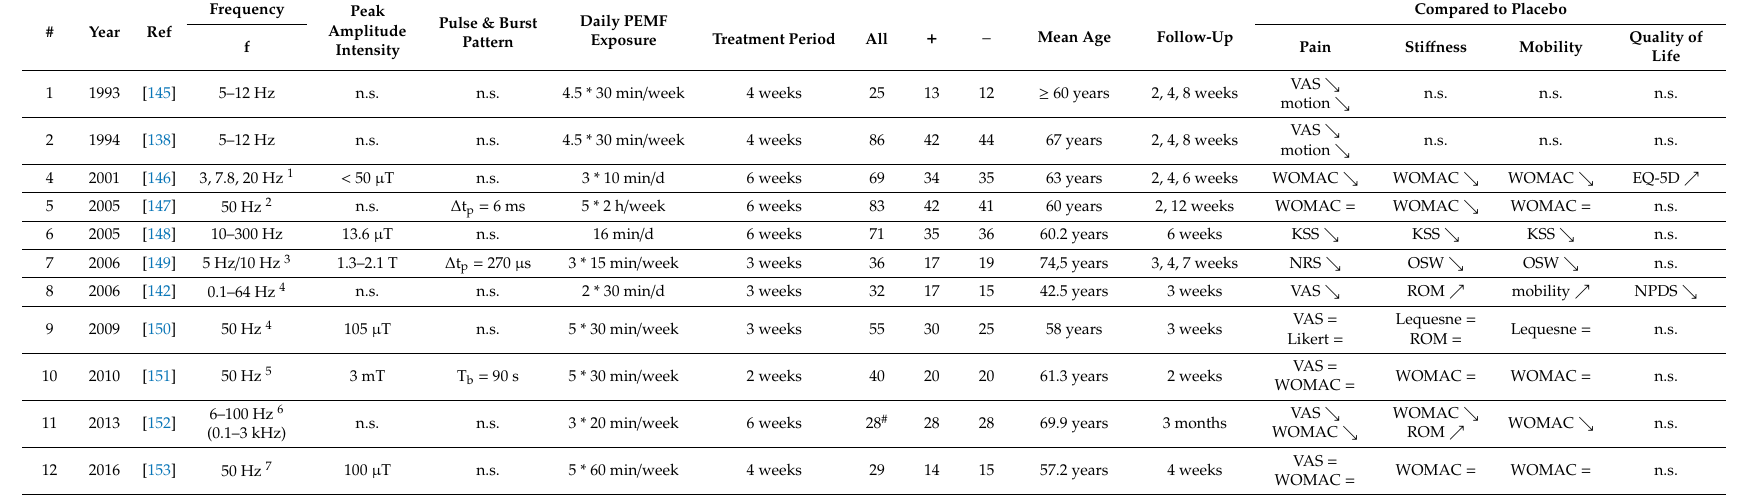
Table 1. Clinical studies (prospective, placebo-controlled, blinded) investigating the e ff ect of ELF-PEMF treatment on osteoarthritis of the knee (adjunct to conservative treatment).